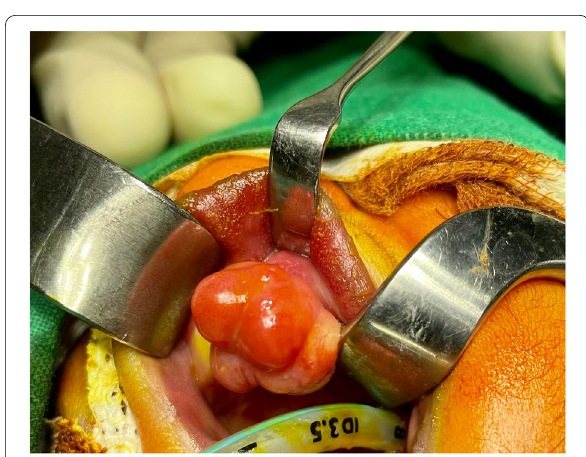
Fig. 2 Per operative picture showing the mass arising from the maxillary alveolar